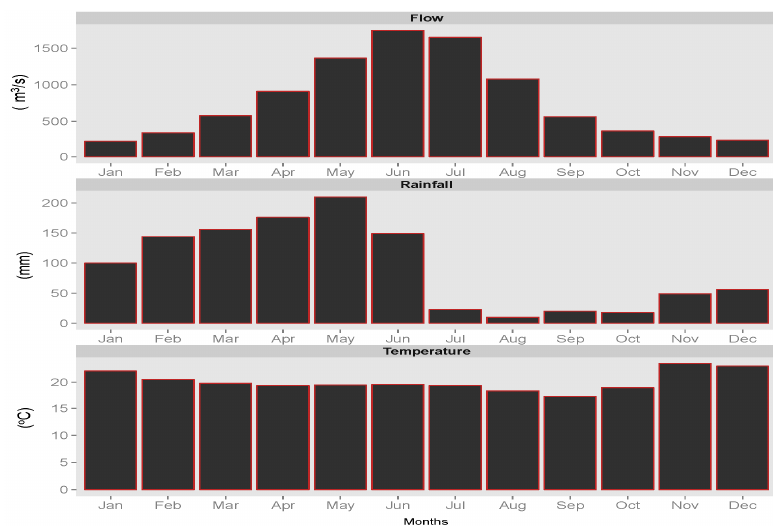
Figure 2. Climate in the Kwanza River Basin, top is mean monthly runoff (m 3 /s), middle is mean monthly rainfall (mm) and the bottom is the mean monthly temperature (°C).